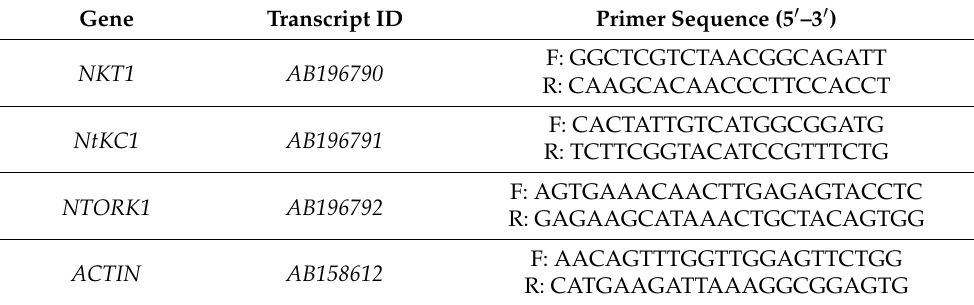
Table 1. Primer sequences of K + channel genes in tobacco used for analyzing gene expression.